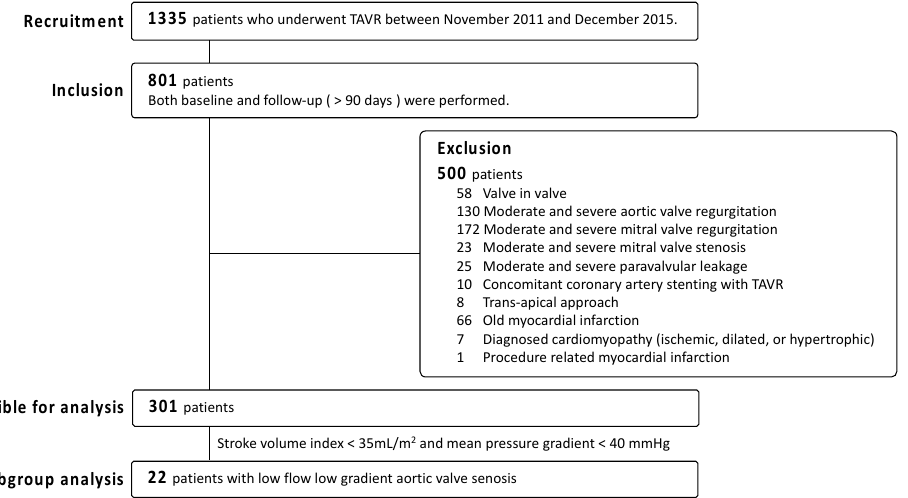
Figure 1. Flowchart of enrollment. TAVR, transcatheter aortic valve replacement.